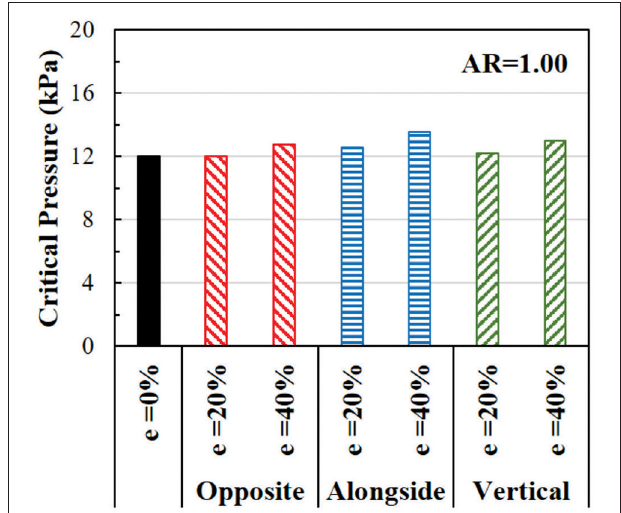
FIGURE 8 | Comparison of the critical buckling pressures of arteries with eccentric cross-section. The effect of lumen eccentric alongside (same), opposite, and vertical to the direction of deflection are